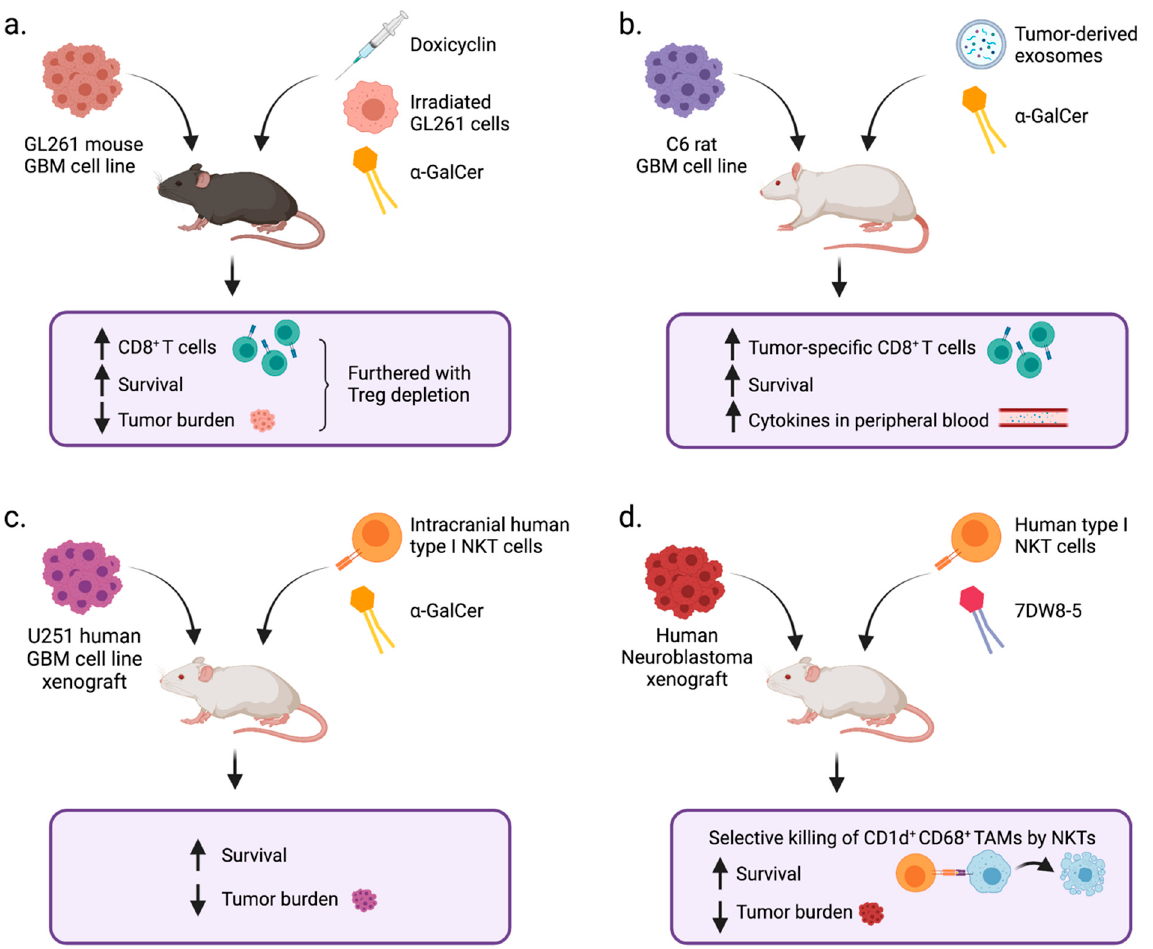
Figure 3. Summary of studies involving NKT cell agonists or NKT cells to treat nervous system cancers. ( a ) Mice implanted with the GL261 mouse GBM cell line were treated with doxycyclin, irradiated tumor cells, and α -GalCer. Mice showed an increase in CD8 + T cells and a decrease in tumor burden with treatment, and this was furthered by additional treatment with Treg depletion via anti-CD25. ( b ) Rats implanted with C6 rat GBM cell line were treated with tumor-derived exosomes and α -GalCer. Rats showed an increase in tumor-specific CD8 + T cells, increased survival, and increased cytokines circulating in peripheral blood with treatment. ( c ) Mice implanted with U251 human GBM cell line xenograft tumors were treated with intracranial adoptive transfer of human type I NKT cells and α -GalCer. Mice showed an increase in survival and a decrease in tumor burden with treatment. ( d ) Mice implanted with human neuroblastoma xenografts were treated with adoptive transfer of human type I NKT cells and 7DW8-5. Mice showed selective killing of CD1d + CD68 + TAMs by NKTs, increased survival, and decreased tumor burden with treatment.